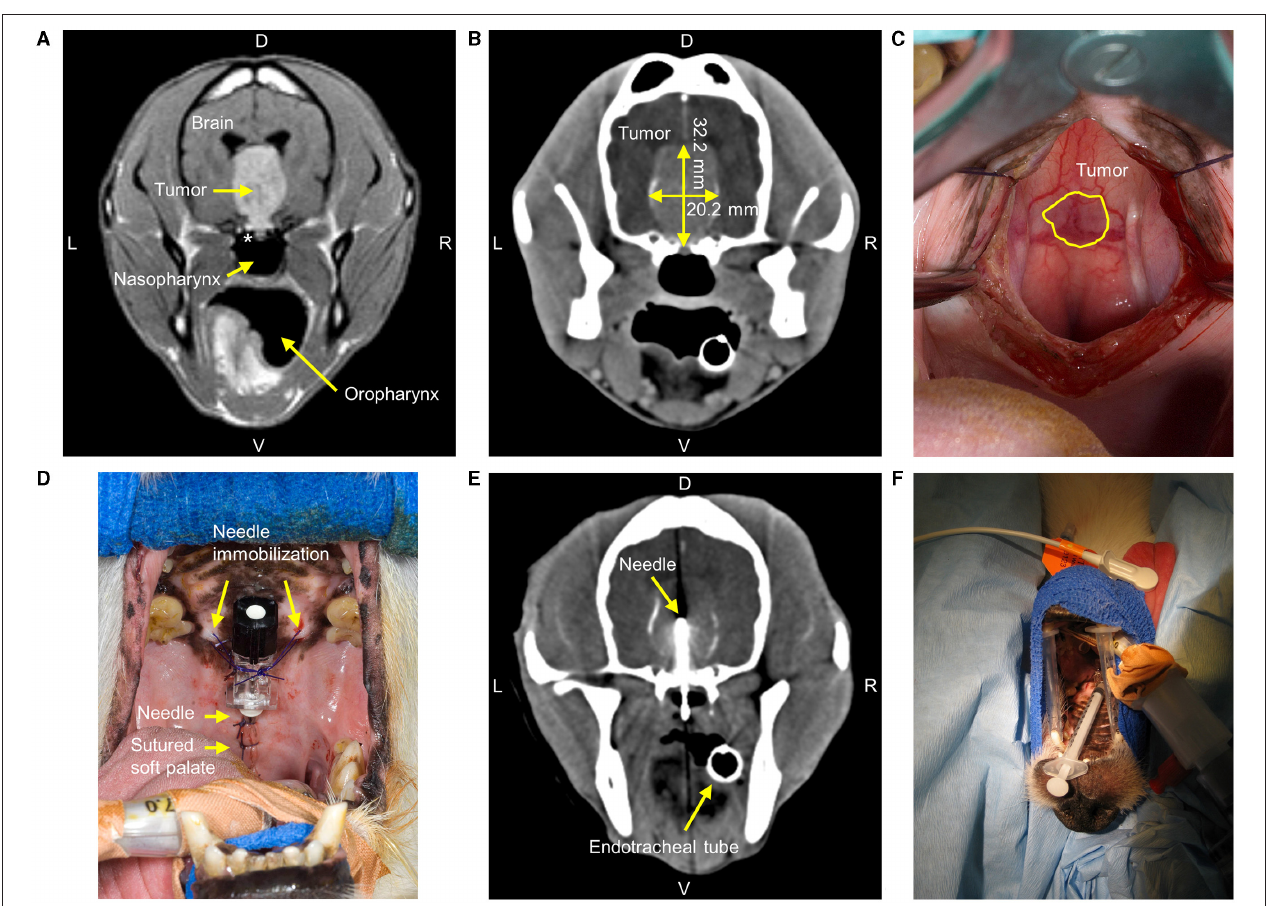
FIGURE 1 | Diagnostic imaging and intratumoral holmium-166 microspheres treatment of a 10-year-old Jack Russell Terrier with a pituitary tumor. (A) Gadolinium-enhanced T1-weighted spin-echo MRI six months before treatment, showing a large hyperintense circumscribed pituitary mass lesion with basisphenoid bone invasion ( * ). L = Left, R = Right, D = Dorsal, V = Ventral. (B) Contrast-enhanced CT (2mm interslice spacing with 0.5mm overlap, tube current 200mA, tube voltage 120 kV) immediately before treatment with longest tumor height and width measured. (C) During the transsphenoidal approach and after retraction of the soft palate, the tumor was visible through the mucoperiosteum. (D) The needle was placed into the tumor center and immobilized with sutures after closure of the soft palate. (E) CT of the skull shows the needle as an imaging artifact with the needle tip in the tumor center. (F) The syringe was attached to the prepositioned immobilized needle for 166 HoMS administration in the tumor center. The dog was positioned on his